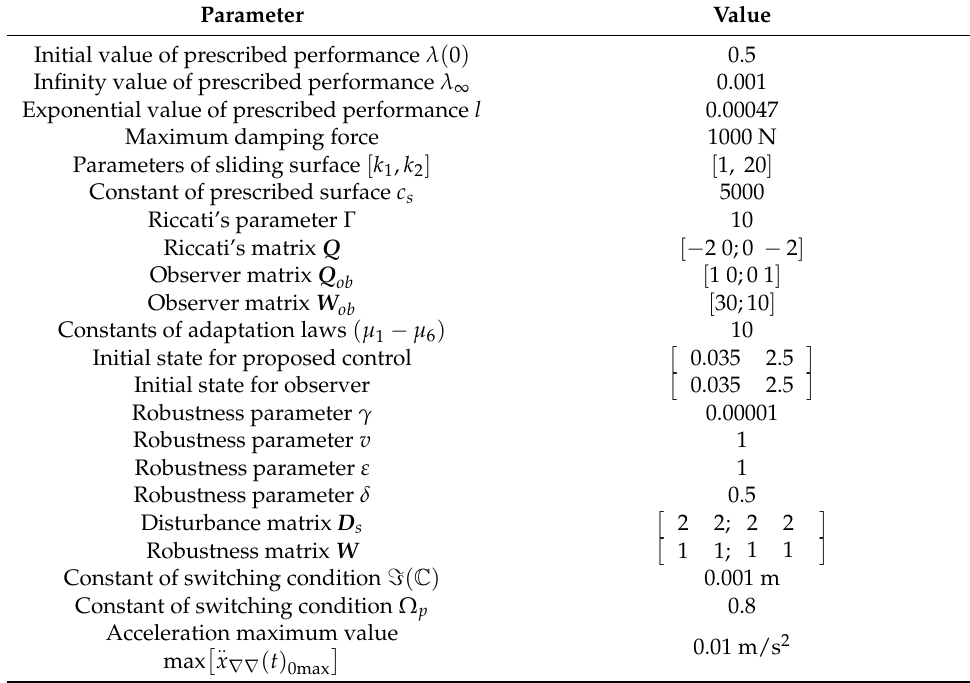
Figure 3. Random step wave road excitation. Table 1. Parameters of the seat suspension for the proposed